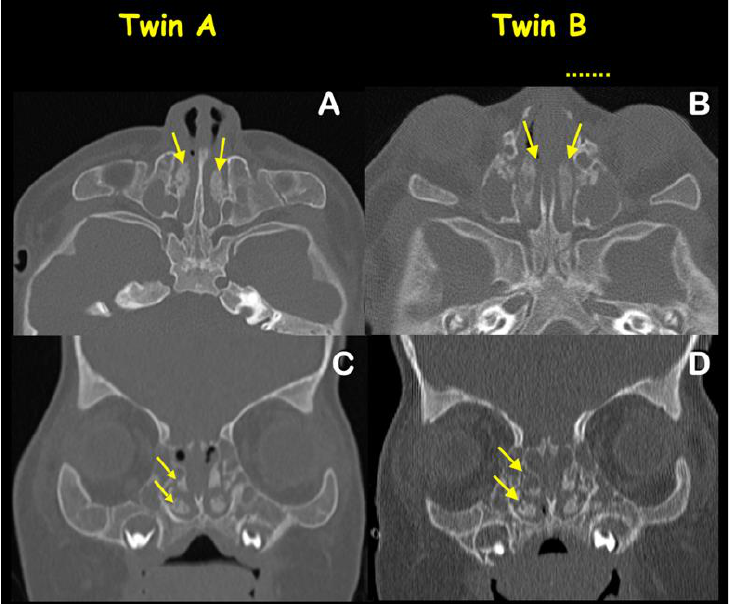
Figure 6. Axial and coronal views CT (bone window) of twins A and B. Obstruction of bilateral nasal cavities (arrows) in ( A ) twin A and ( B ) twin B. Bilateral hypertrophy of turbinates (arrows) in ( C ) twin A ( D ) twin B.